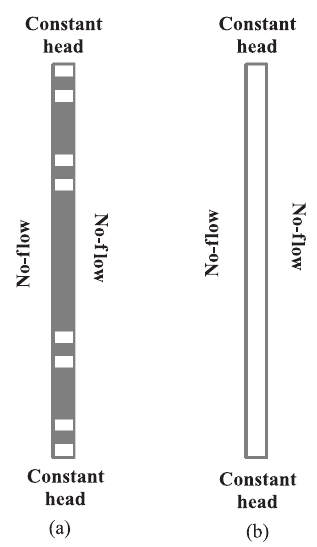
Figure 1. Representation of one-dimensional profiles and boundary conditions for layered (a) and pure phase (b) systems. White represents Clay Loam and gray Silt Loam soil